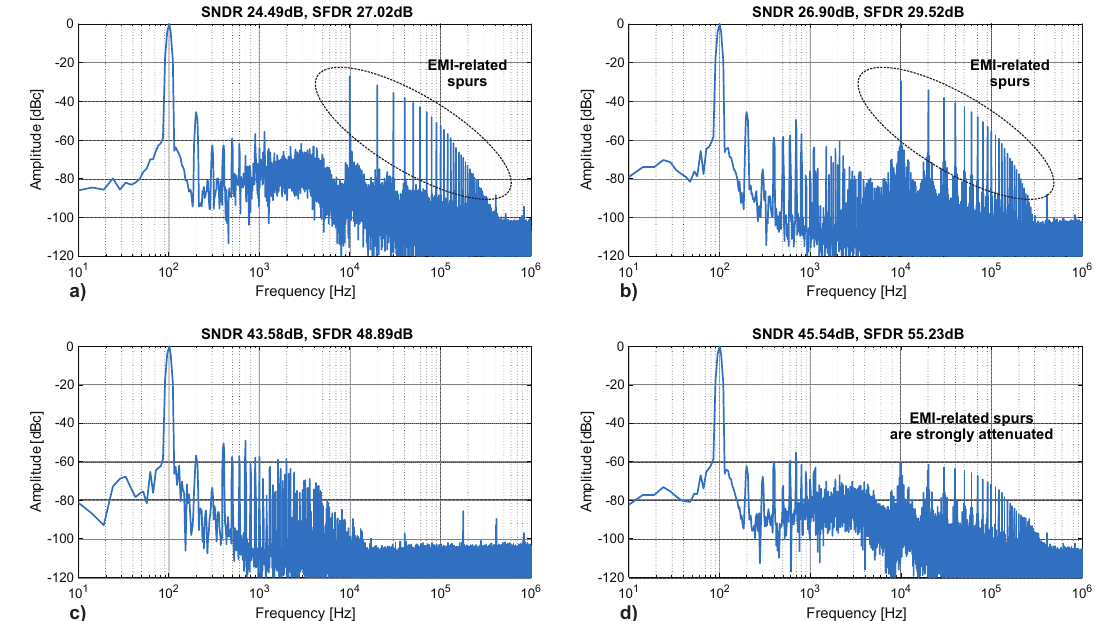
Figure 16. Spectra of the acquired signals under a damped exponential modulated EMI in Figure 15: ( a ) OPA2277 opamp output voltage with EMI injection; ( b ) MCP6V02 opamp output voltage with EMI injection; ( c ) nominal input signal spectrum as in Figure 8b; ( d ) Output voltage with EMI injection estimated starting from the EMI corrupted waveforms in ( a , b ), by the proposed EMI-induced errors suppression procedure with α =